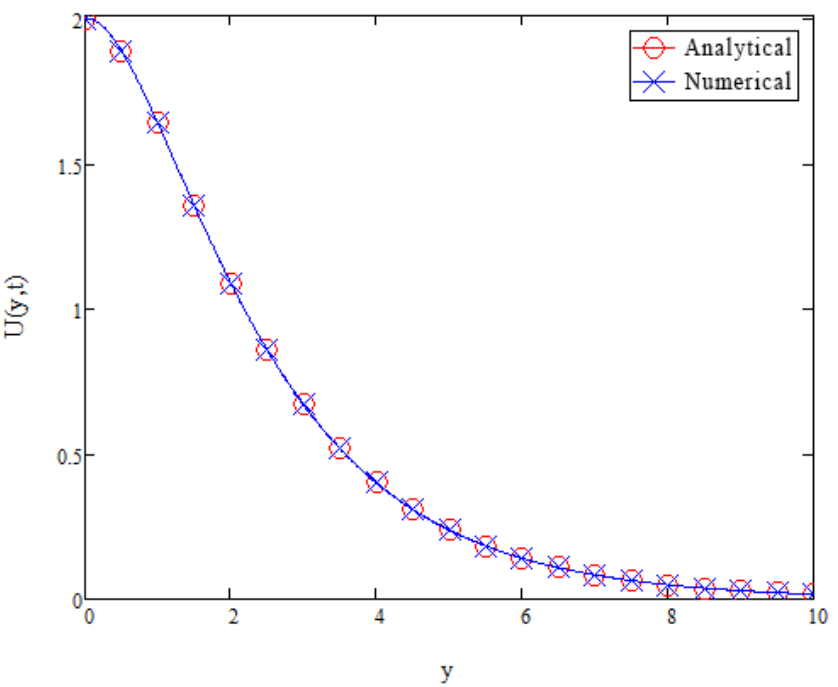
Figure 2. Velocity profile for analytical solution presented in Equation (20) validated with numerical solution using Zakian’s method.